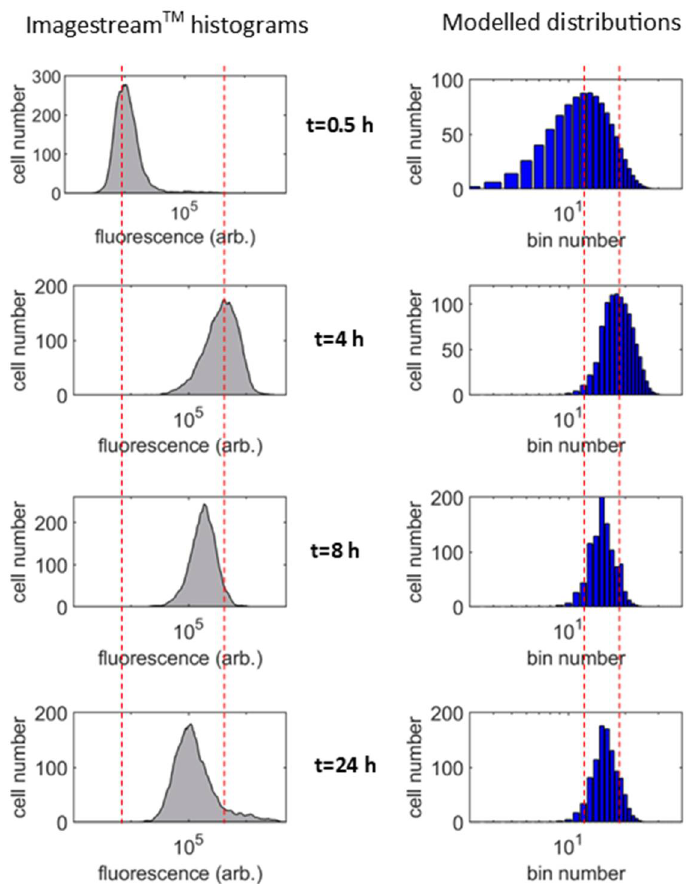
Figure 5. Measured histograms of fluorescence intensity per cell [28] (left column) and simulated distributions (right column), for ND7/23 neuronal cells incubated with TMC16 nanoparticles. Red lines provide visual reference points, against which histogram movement can be assessed.